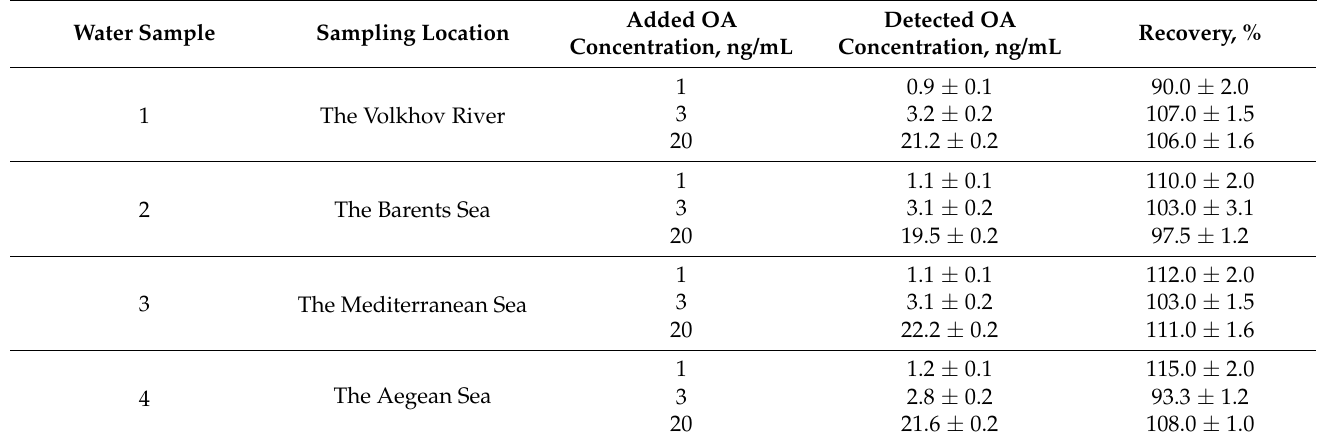
Table 1. Recoveries of OA from river water and seawater ( n = 3).